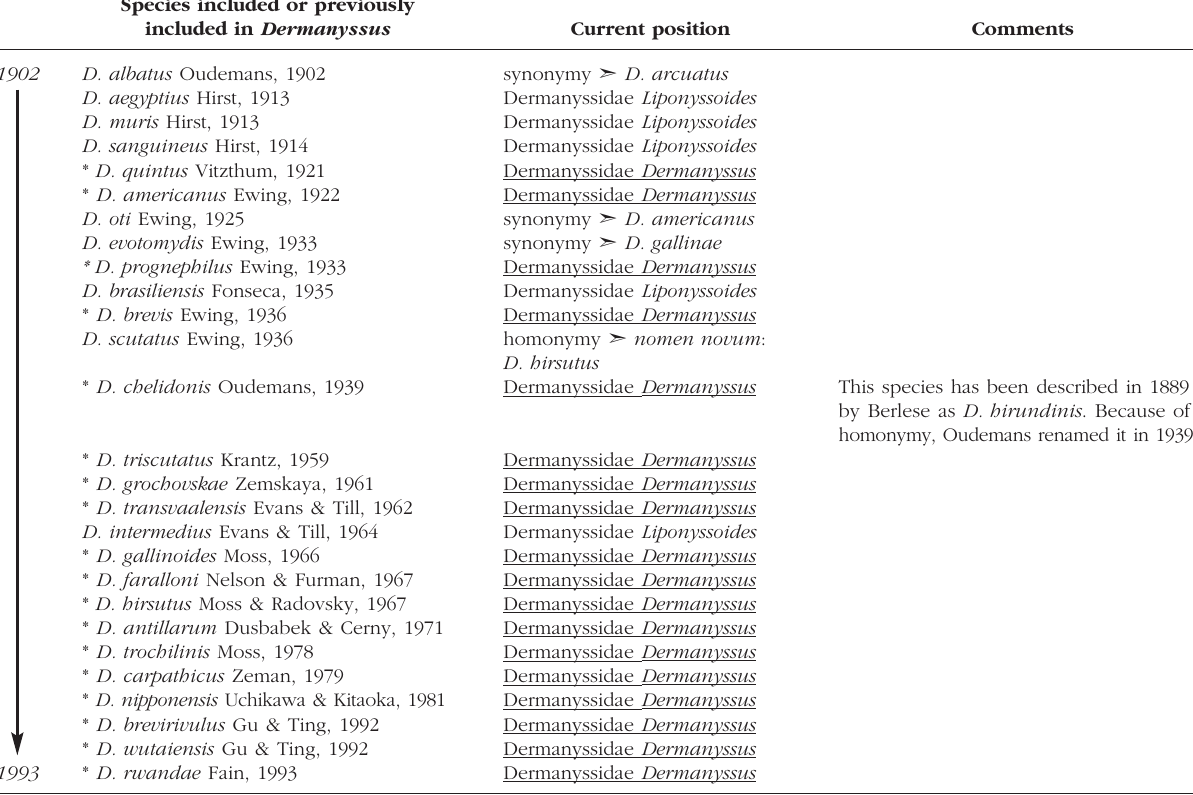
Table I. – Species included or previously included in Dermanyssus listed in chronological order with their present position/status. Spe- cies names preceded by * are here included in Dermanyssus